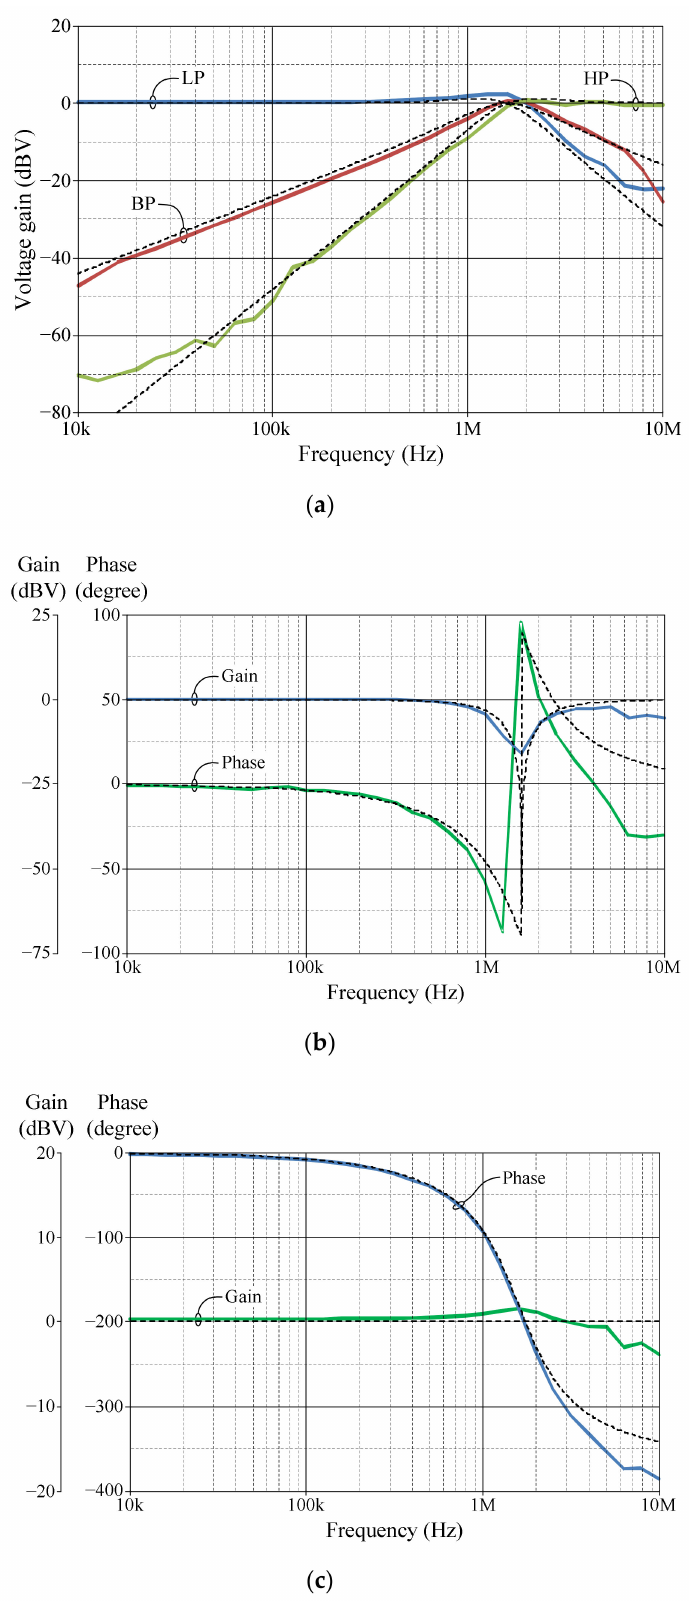
Figure 20. Ideal (dashed line) and measured (solid line) frequency responses for VM: ( a ) LP, BP and HP; ( b ) BS; ( c )